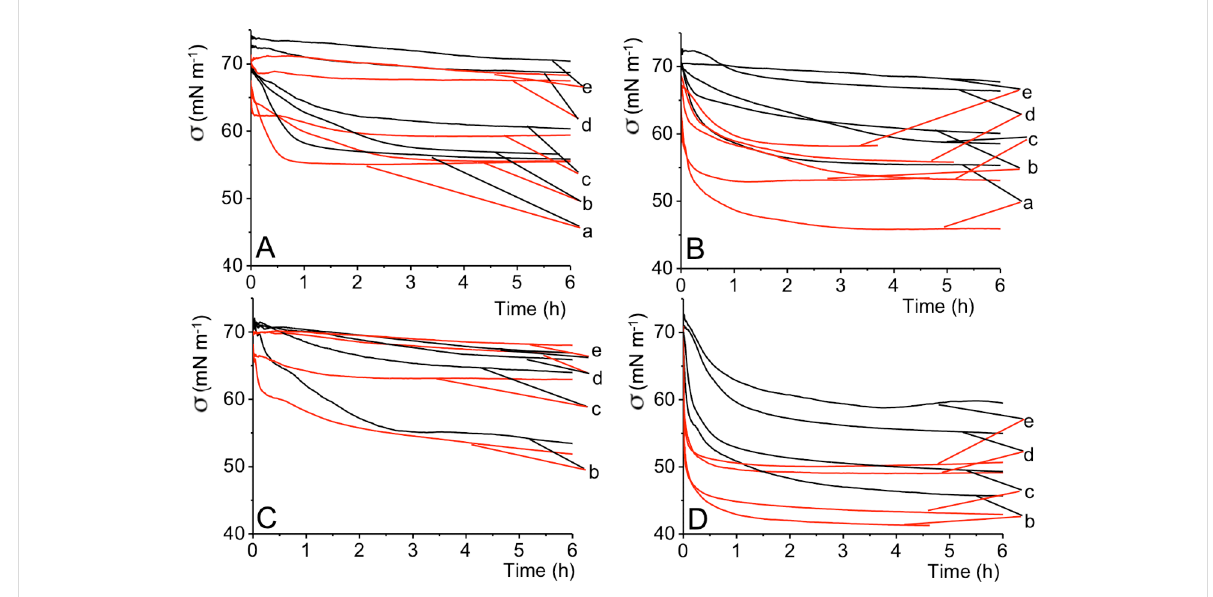
Figure 3: Adsorption kinetics of IONPs grafted with various dendrons measured at 25 °C: A) C 2 H 5 OEG 8 Den, B) C 2 F 5 OEG 8 Den, C) C 4 H 9 OEG 8 Den and D) C 4 F 9 OEG 8 Den, at various Fe concentrations: a) 0.1; b) 0.05; c) 10 − 2 ; d) 10 − 3 and e) 10 − 4 mg mL − 1 . The dendronized IONPs were exposed to air (black) or to F -hexane-saturated air (red).